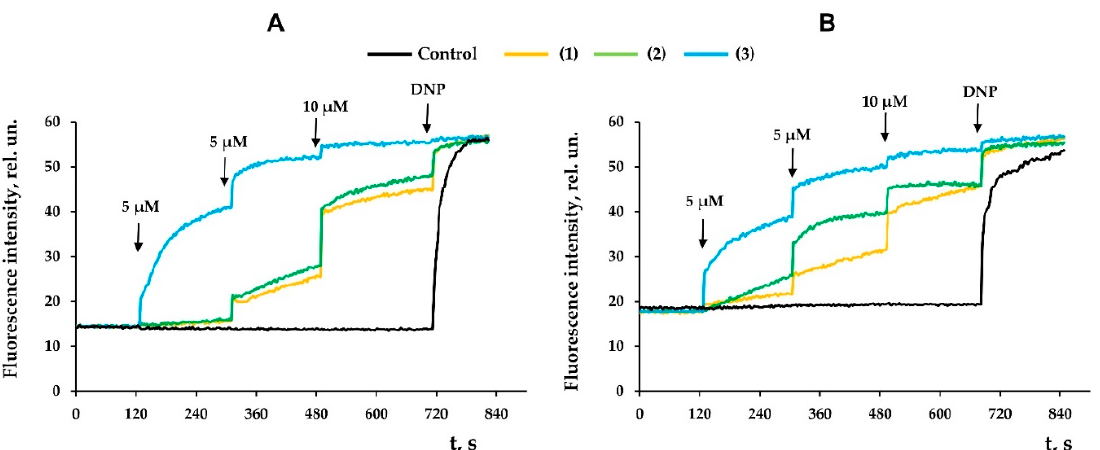
Figure 4. Effects of modified levopimaric acid diene adducts on membrane potential of rat liver mitochondria fueled by glutamate/malate ( A ) or succinate ( B ). Black curve (control) obtained in the absence of tested compounds. DNP (50 μ M) was added to induce maximum decrease in membrane potential. The picture shows typical curves recorded with the same sample during the same experiment. Similar results were observed in two other independent experiments.